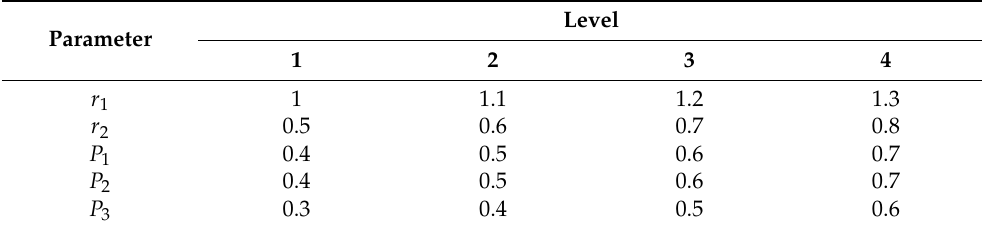
Table 3. Level of